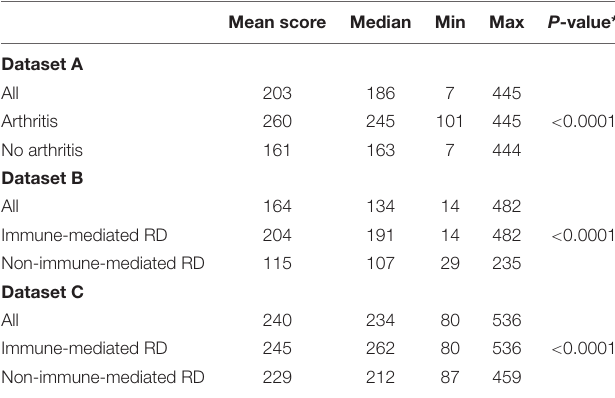
TABLE 2 | Total Rheumatic? score in each